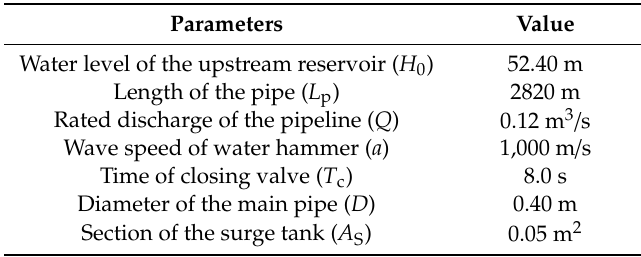
Table 1. Parameters of the pipe and surge